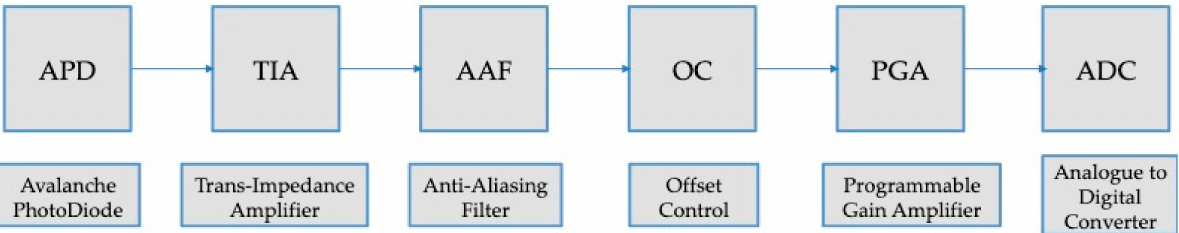
Figure 14. Electronic chain diagram from photon detector to digitised